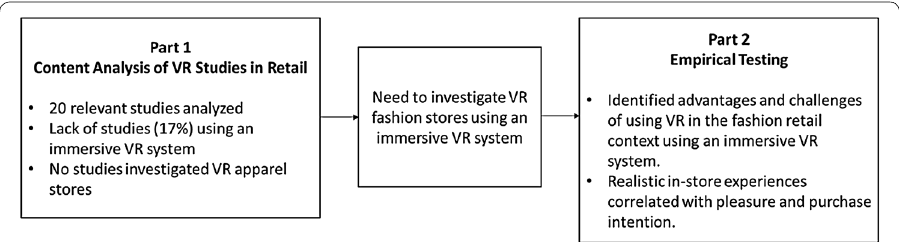
Fig. 1 Summary of research processes and